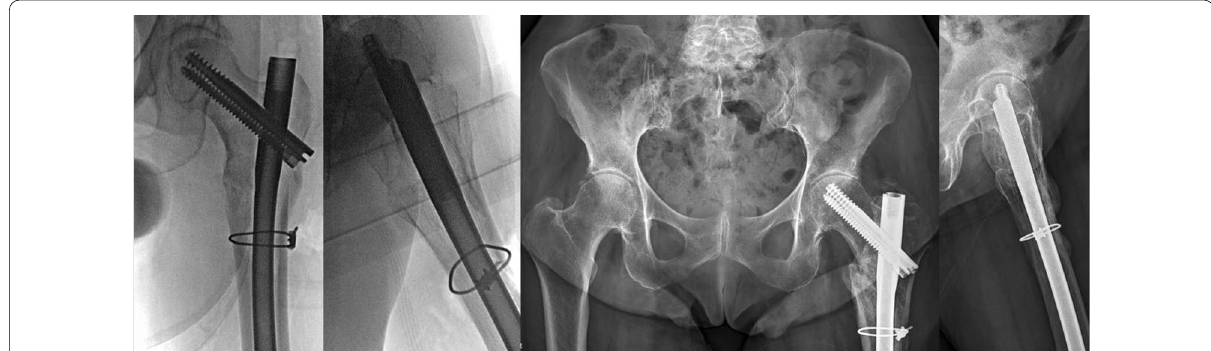
Fig. 4 (Left) Anteroposterior (AP) and lateral view of the left hip obtained at the time of revision surgery showing restoration of proximal femoral length and neck shaft angle. (Right) AP pelvis and lateral hip X-ray obtained 6 months postoperatively showing full union of the fracture with no